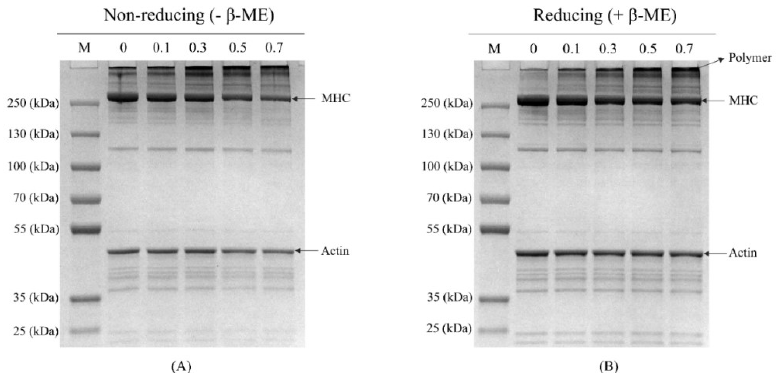
Figure 3. Effect of MDA on MP proteins profile. Non-reducing condition ( A ), reducing condition ( B ). M, protein marker; MHC, myosin heavy chain.